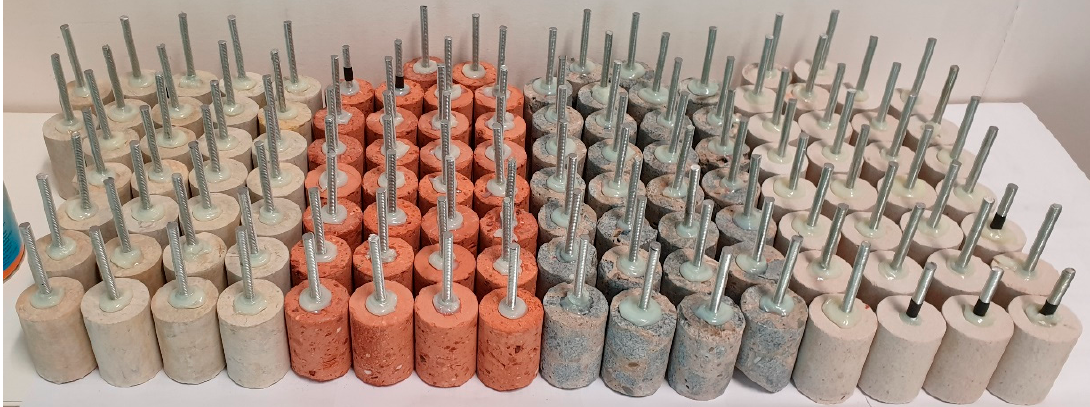
Figure 6. Assembly of all test specimens with glued threaded rods.